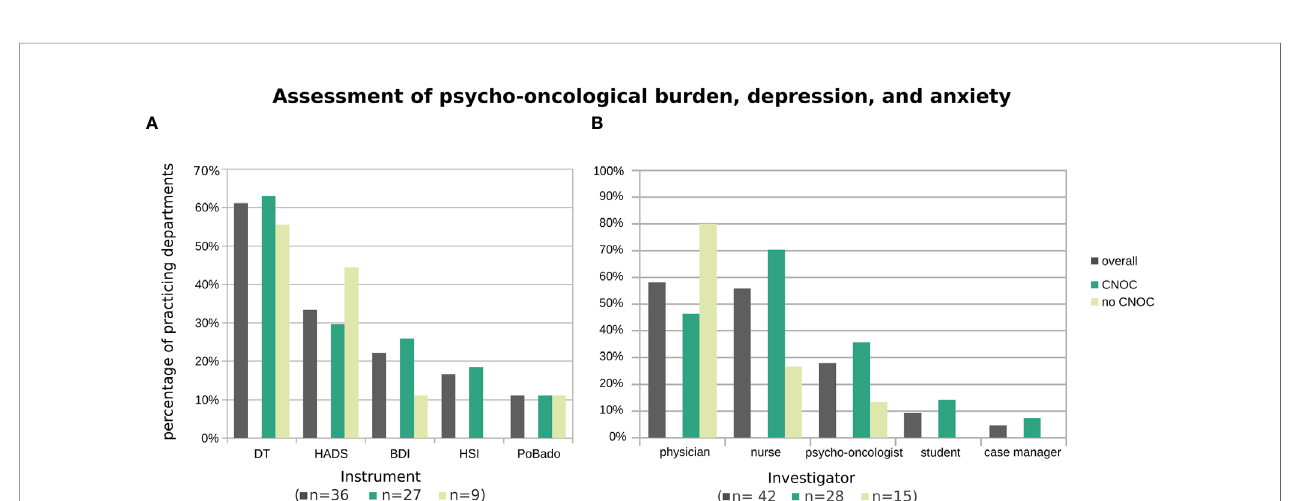
FIGURE 3 | Applied psycho-oncological assessment instruments (A) and administering professionals (B) , overall and strati fi ed by certi fi cation type of participating departments. Histograms are based on replies from n departments practicing assessment of psycho-oncological burden, depression, and anxiety (with n provided by subgroup in the x-axis label). Multiple instruments (or multiple types of professionals) were named by 39% (29%) of